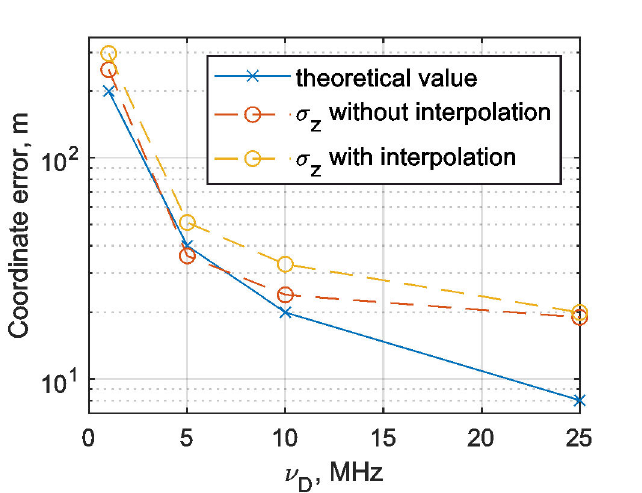
Figure 19. Dependence of disturbance localization error on sampling